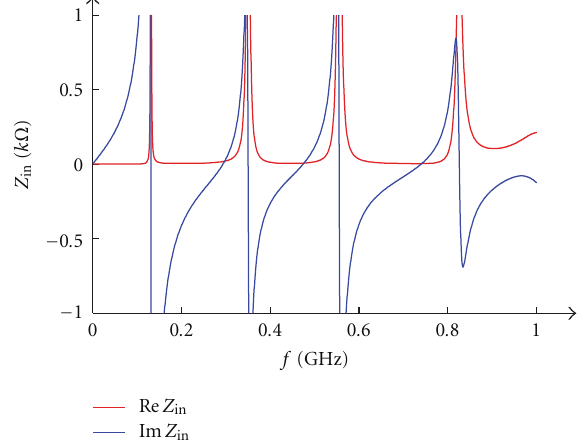
Figure 5: Input impedance of the spherical helix depicted in Figure 4.